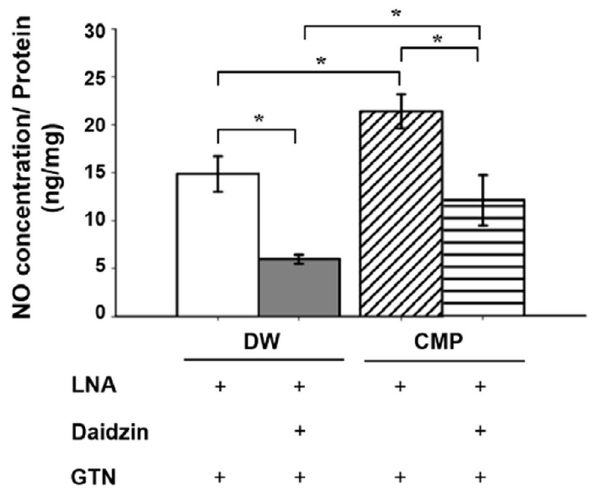
FIGURE 10 - Effects of CMP (1 g/kg) or distilled water (DW, control) consumption by the middle-aged male rats on NO concentration/protein (ng/mg) in aortic rings. * Significantly lower than their corresponding control, and † significantly higher than the DW control group, P <